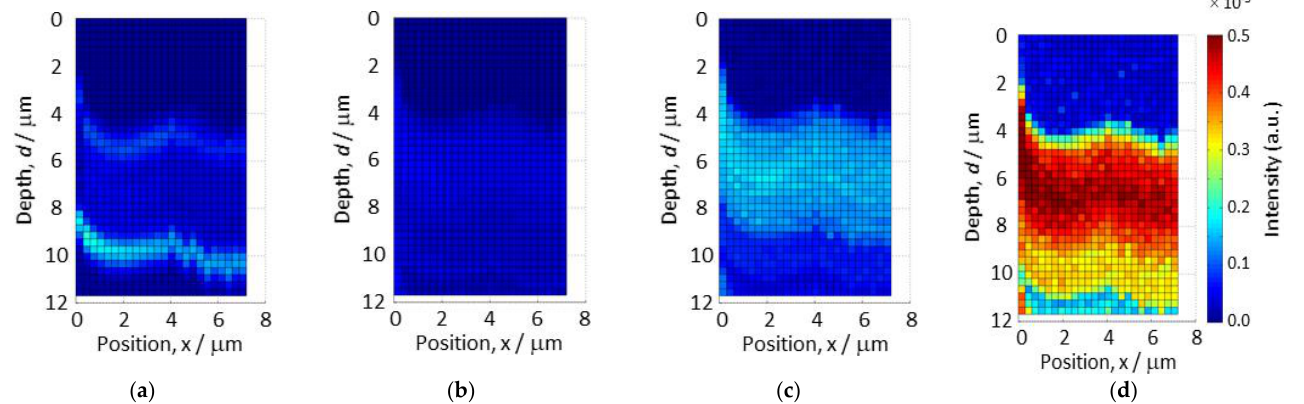
Figure 5. Light emission maps at different energies: ( a ) 1.4 eV, ( b ) 2.0 eV, ( c ) 3.3 eV, and ( d ) 3.6 eV, in CuO/Cu 2 O bi-layered film prepared on the ZnO/FTO/SLG substrate.